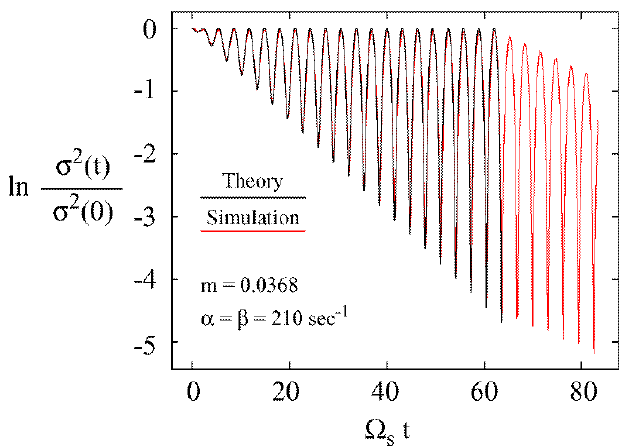
FIG. 9. (Color) Comparison between theory [Eq. (19)] and simulation, including radiation damping, but with no quantum